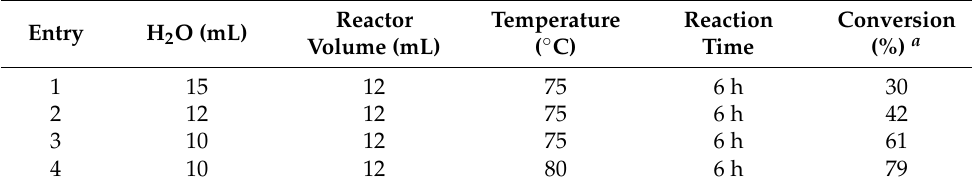
Table 5. Reaction conditions and conversions of second reaction step in a flow reactor. Reactor Volume (mL) Entry H 2 O (mL)